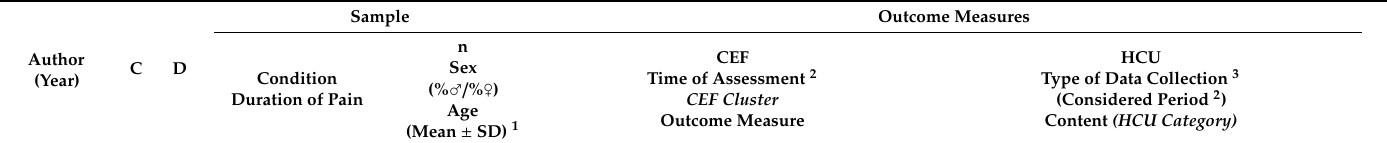
Table A2. Characteristics of the included